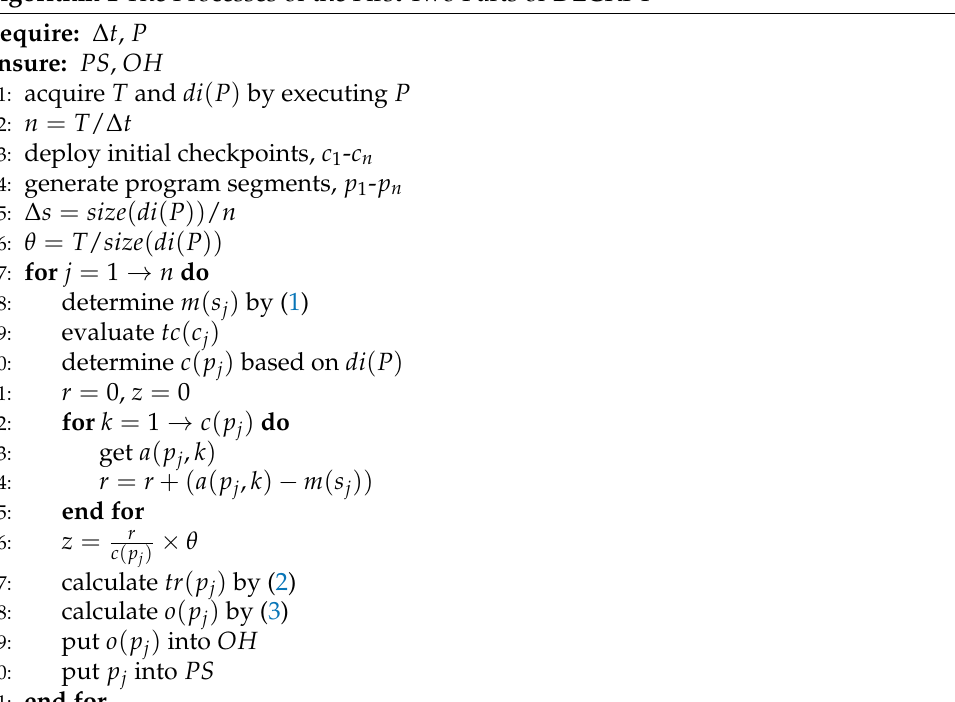
Algorithm 1 The Processes of the First Two Parts of